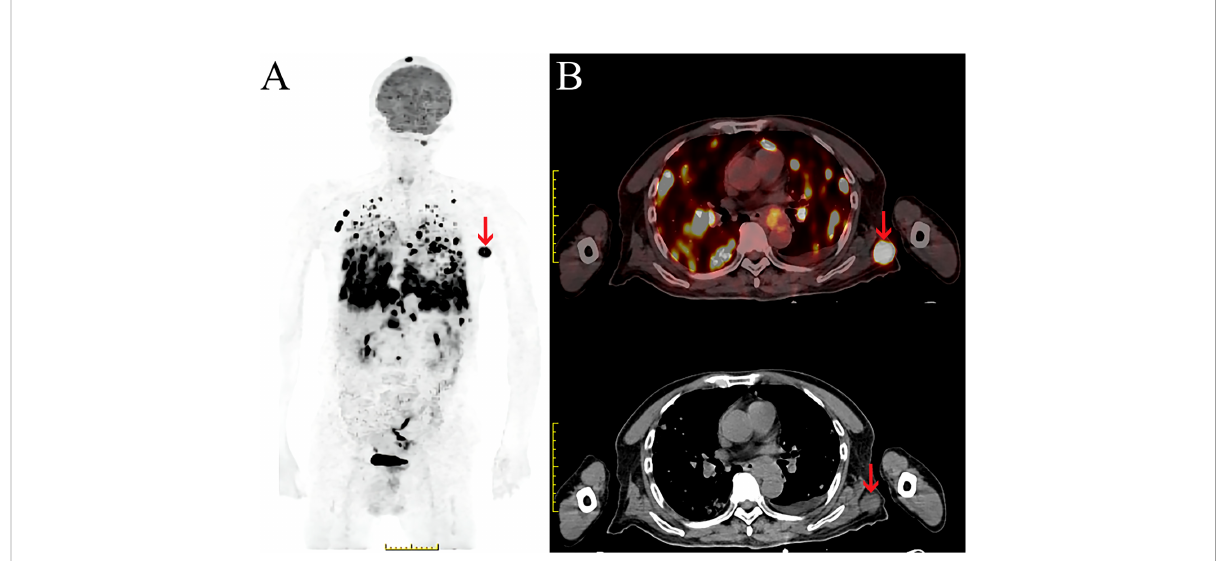
FIGURE 3 PET/CT scan of subcutaneous soft tissue metastasis in the left posterior thorax. (A, B) . (A) Maximum intensity projection (MIP) image of the whole body demonstrates a large FDG avid nodule in the left thorax (red arrow). (B) Fused PET/CT and CT axial image demonstrates a large FDG avid nodule in the left posterior thorax (SUVmax=20.3) (red arrow).